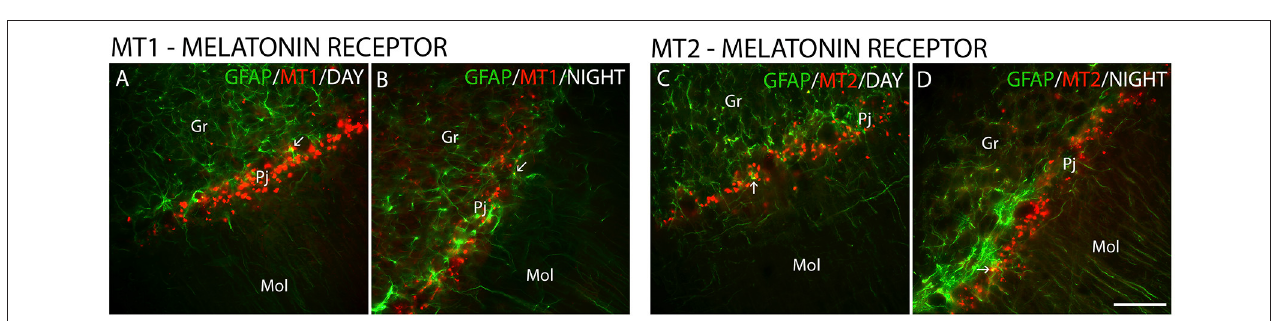
FIGURE 4 | The distribution of GFAP, MT 1 and MT 2 proteins in the cerebellar cortex in the primate Sapajus apella . Photomicrographs of frontal brain sections show MT 1 protein (A,B) (red) or MT 2 protein (C,D) (red) and GFAP (green) at two time points, one during the day (ZT 10) and another at night (ZT 19). The arrows indicate the co-localization (merge) of GFAP and melatonin receptors. Bar = 100 µ